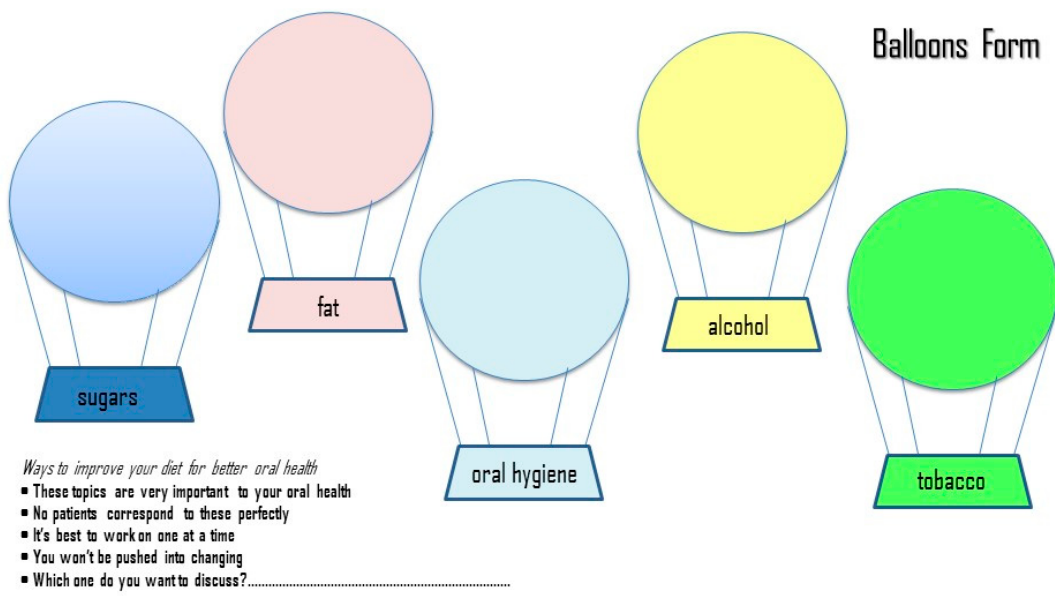
Figure 1. Balloons’ form. Adapted for diet oral health coaching from [145,146].